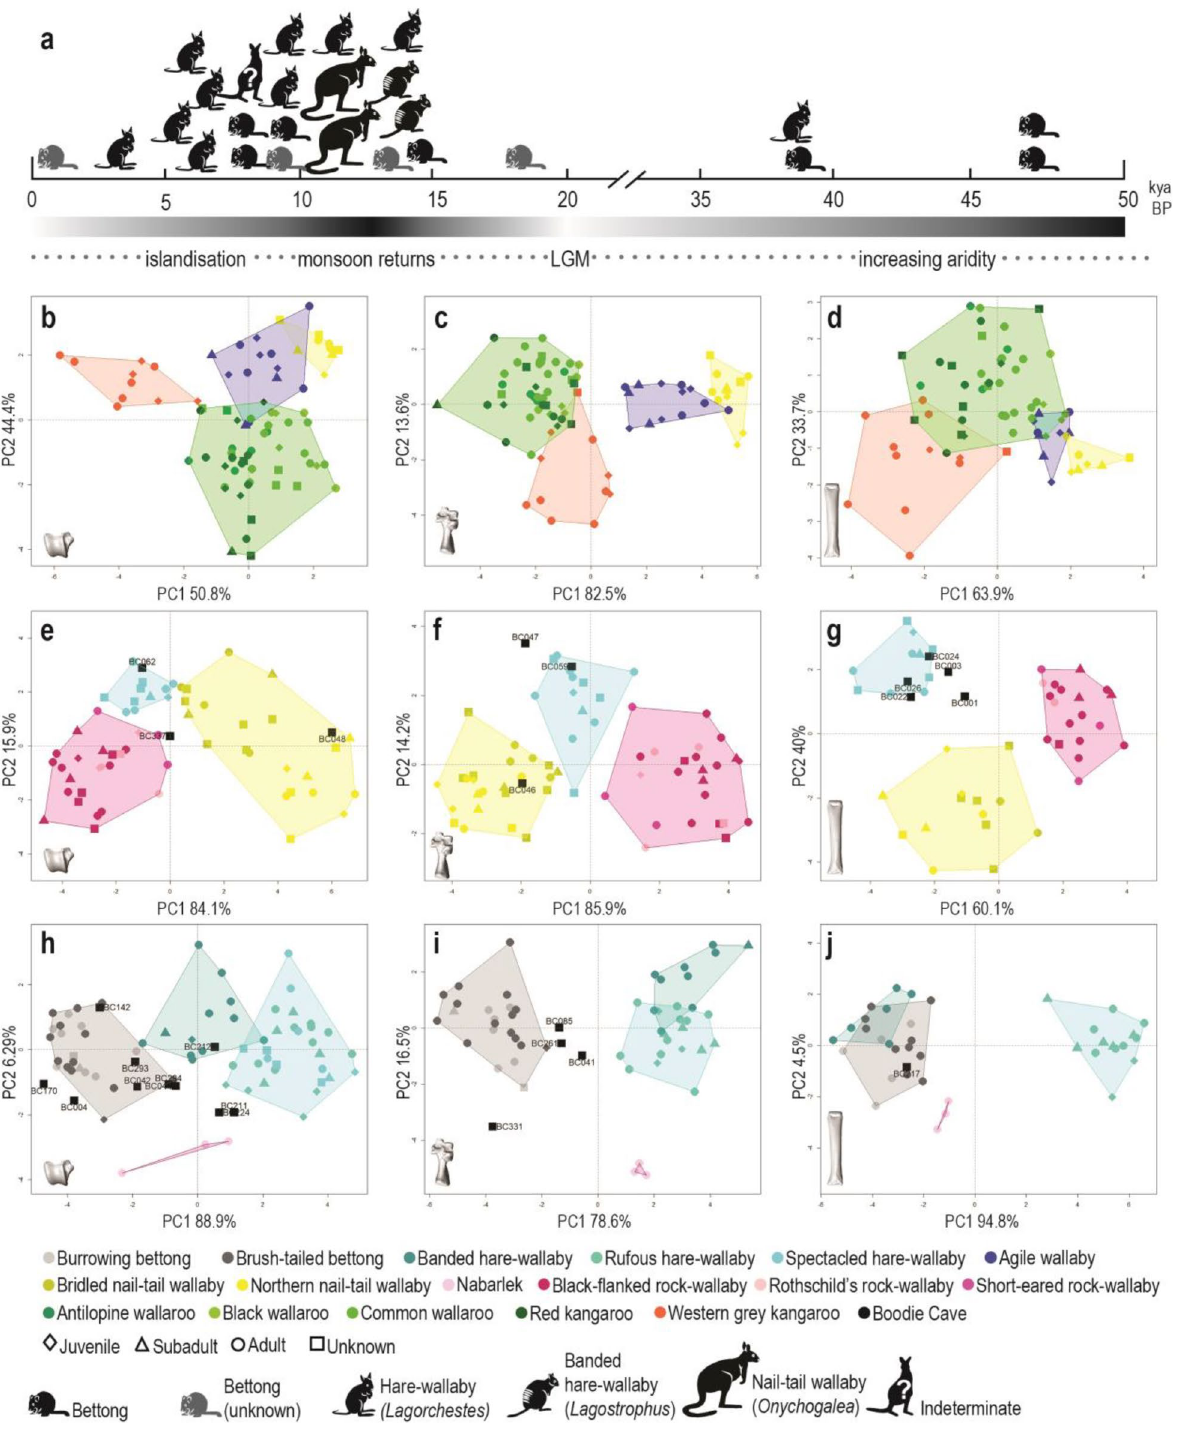
Figure 2. Taxonomic classification of macropod pes bones by discriminant analysis. ( a ) macropod genera in Boodie Cave over time; ( b–d ) classification of large macropod astragali (left), calcanea (middle) and fourth metatarsals (right) by genus; ( e–g ) classification of medium macropod astragali (left), calcanea (middle) and fourth metatarsals (right) by genus; ( h–j ) classification of small macropod astragali (left), calcanea (middle) and fourth metatarsals (right) by genus. Figure generated with R (v.4.1.0) (www. cran.r- proje ct. org) and Adobe Indesign (v16.4) (www. adobe.